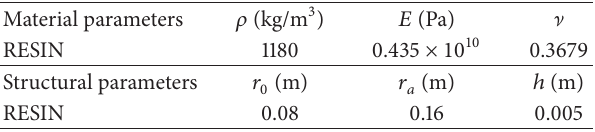
Table 1: Material and structural parameters. Table 2: Material parameters and structural